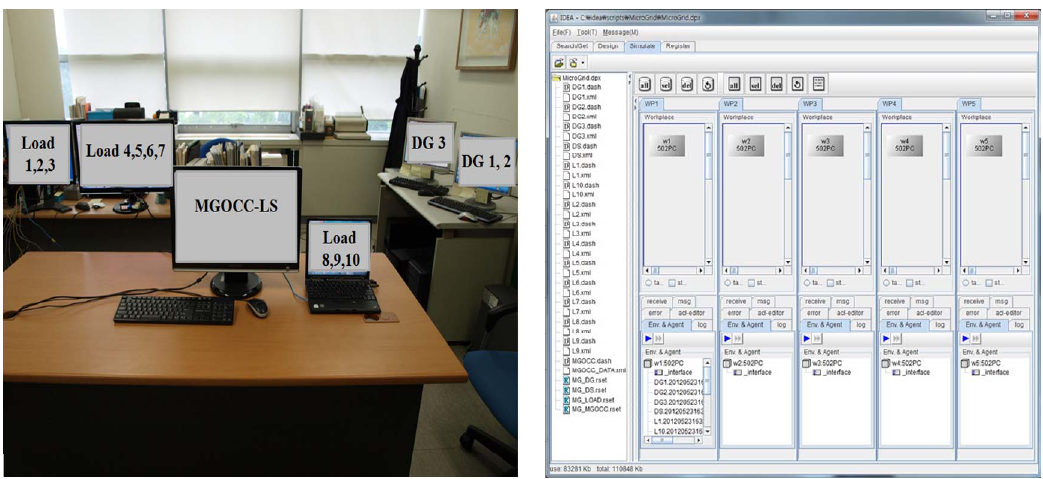
Figure 5. The implemented system in a distributed